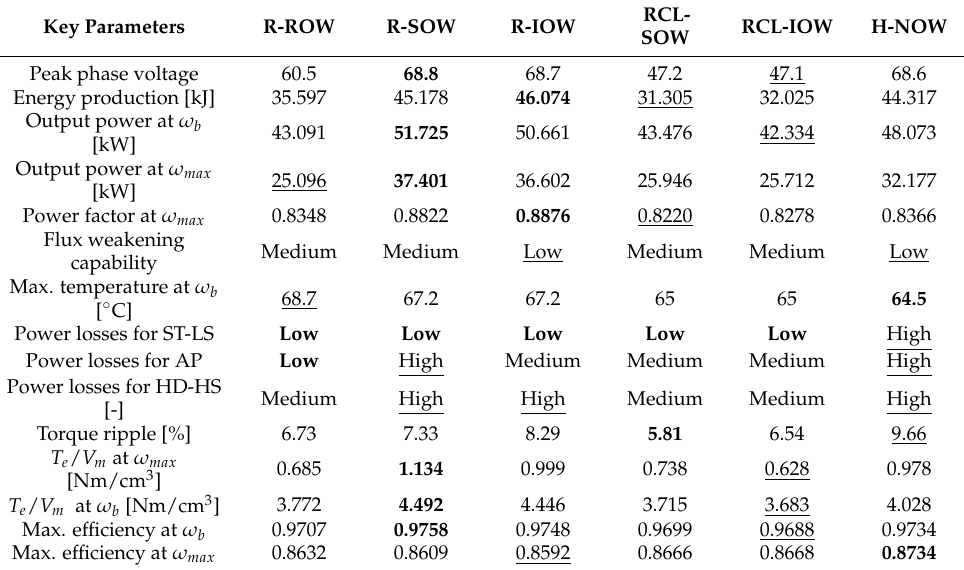
Table 5. Comparative summary of electromagnetic performance of the considered arrangements. Key Parameters